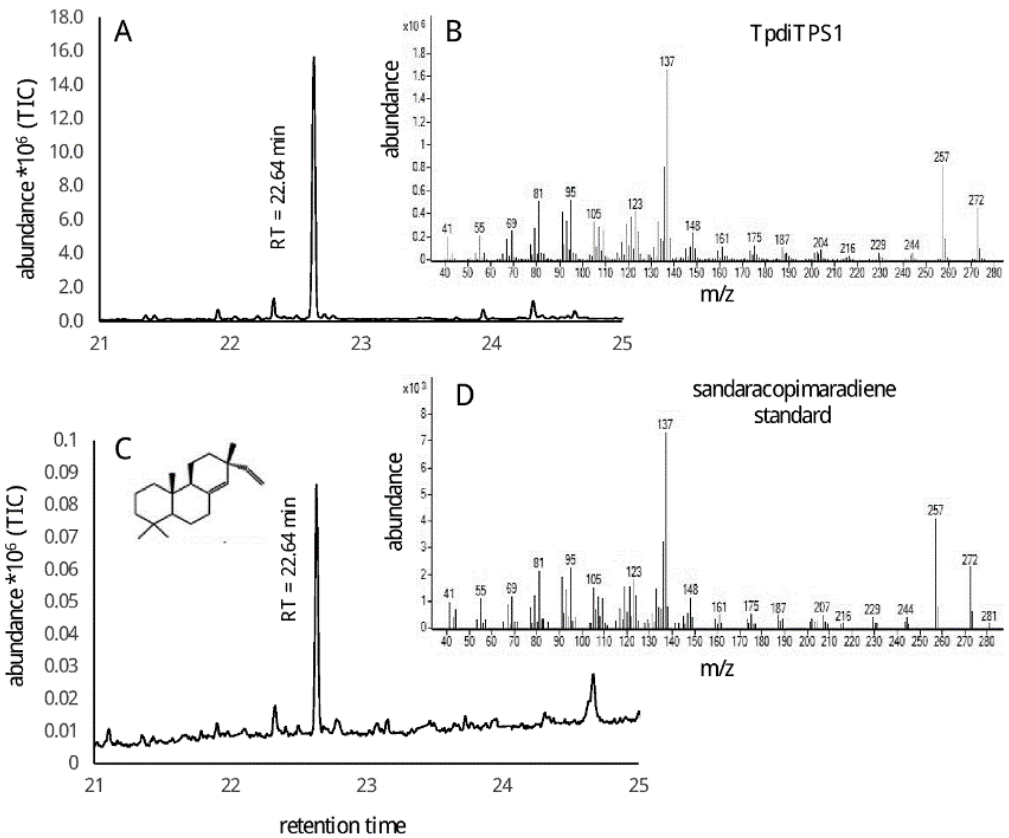
Figure 4. GC-MS analysis of sandaracopimaradiene produced by TpdiTPS1 synthase from normal- copalyl diphosphate (CDP); ( A ) = total ion chromatogram (TIC), ( B) = mass spectrum of sandaracopimaradiene, ( C , D ) = TIC and mass spectrum of an authentic standard of sandaracopimaradiene produced by Aspergillus niger sandaracopimaradiene synthase (AnCPS-PS) [61].